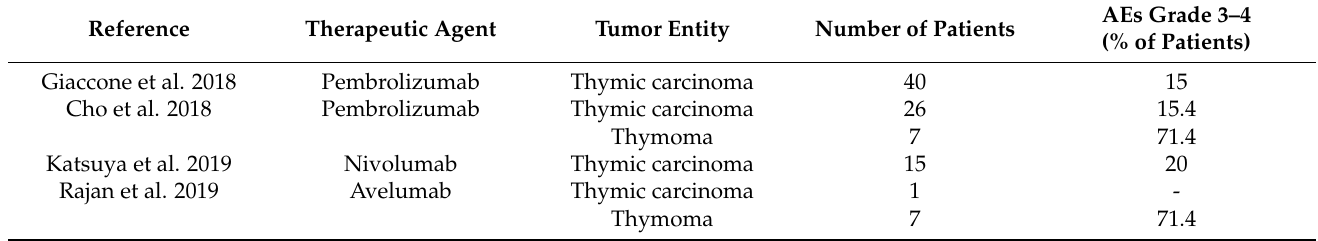
Table 2. Rates of Grade 3–4 adverse events (AEs) (according to the Common Terminology Criteria for Adverse Events) in clinical trials evaluating immune checkpoint inhibition in thymic epithelial tumors. Studies including patients with Thymoma report higher rates of severe AEs in these